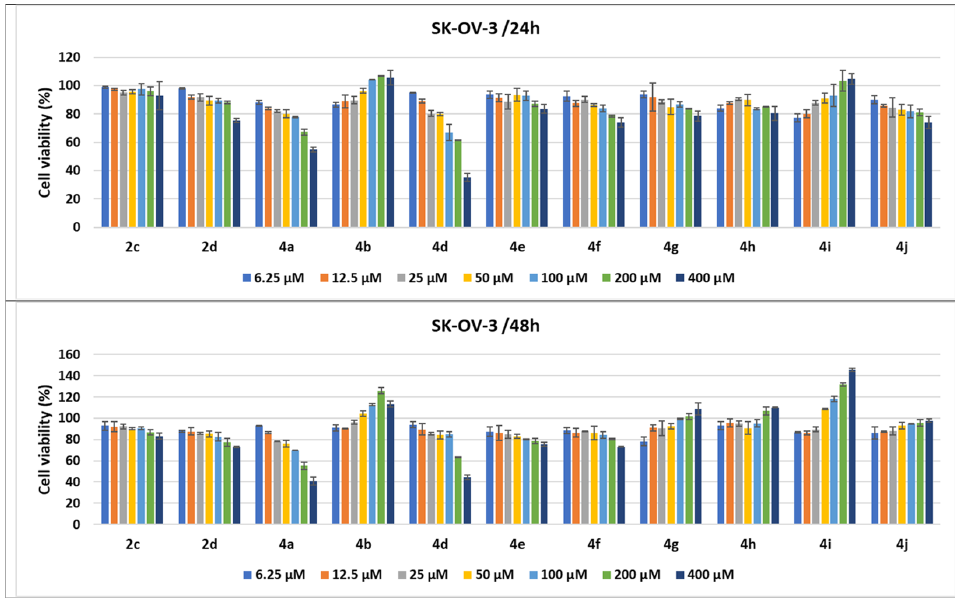
Figure 12. Antitumor effect of pyrrole derivatives against SK-OV-3 ovary cancer cells. The viability of the SK-OV-3 cells was measured after treatments with scalar concentrations of pyrrole compounds for 24 or 48 h and compared to that of untreated control cells. Data are expressed as the mean values ± standard deviations (SDs) of three different experiments ( n = 3 ).